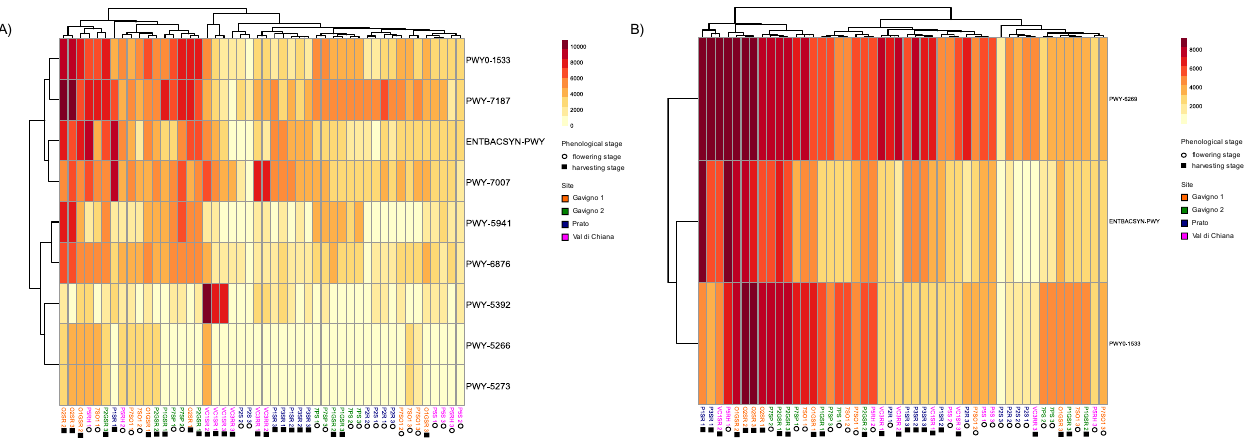
Figure 5. Metabolic pathways mainly contributing to differences among localities ( A ) and phenological stages ( B ). See Table S1 for samples codes.